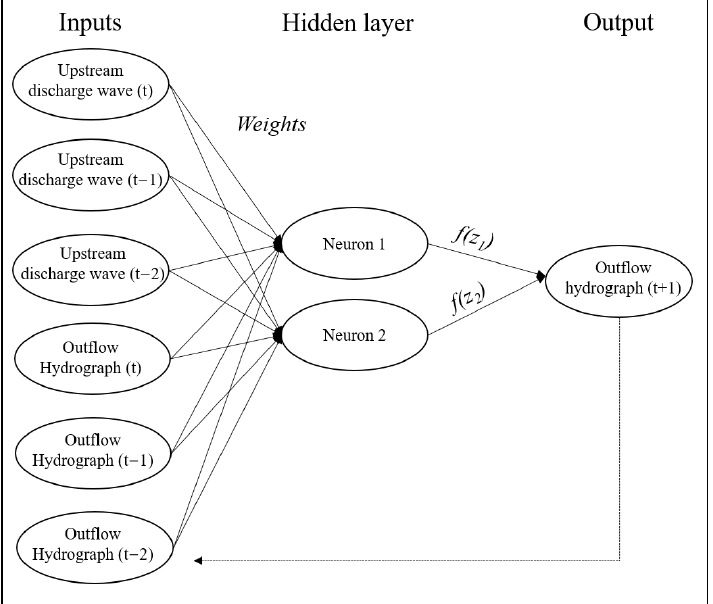
Figure 5. Setup of the trained NARX networks with the upstream discharge wave and predicted outflow hydrographs as input, considering two time delays, and two neurons in the hidden